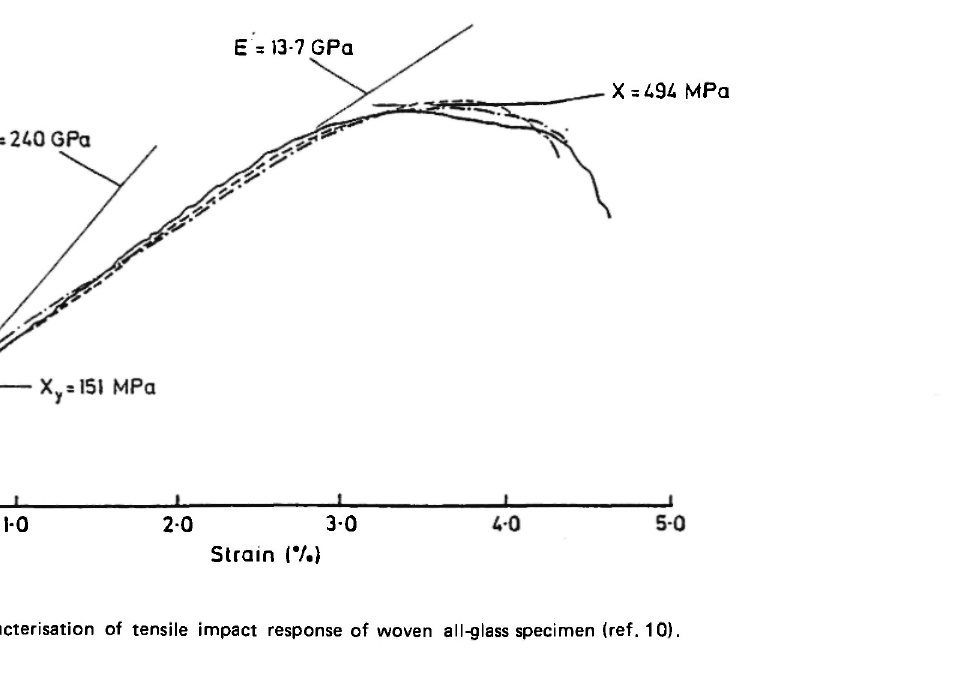
Fig. 25: Characterisation of tensile impact response of woven all-glass specimen (ref.